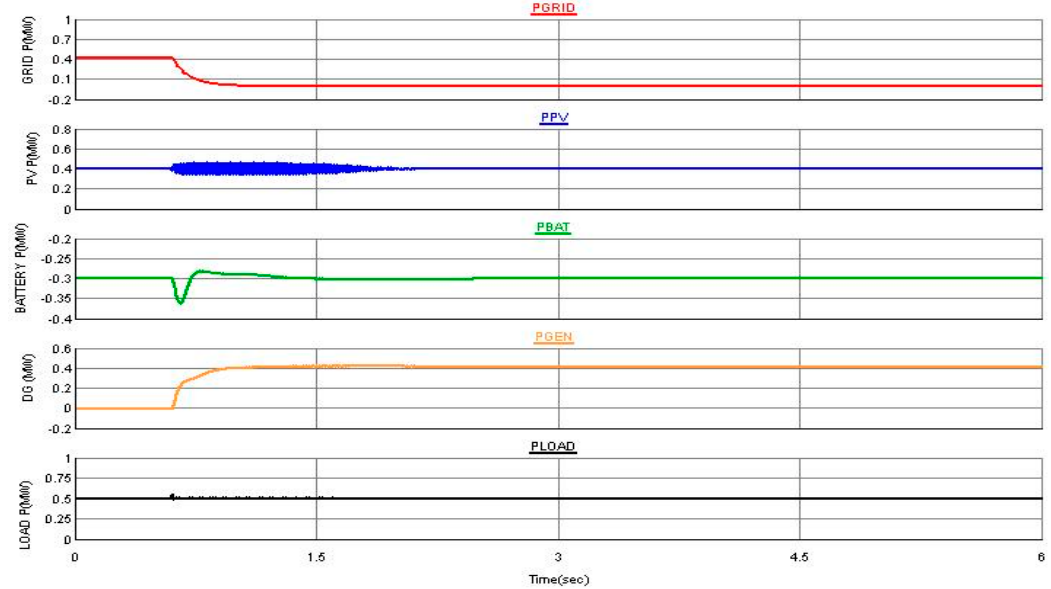
Figure 15. Grid power P GRID , PV array output power P PV , battery power P BAT , generator power P GEN and load power P LOAD.